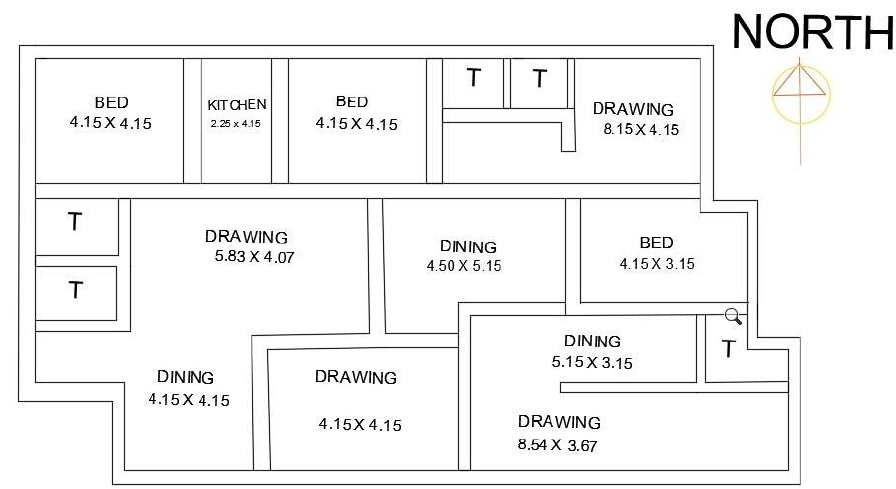
Figure 5. 2D plan of the existing first floor building. All dimensions are in m.